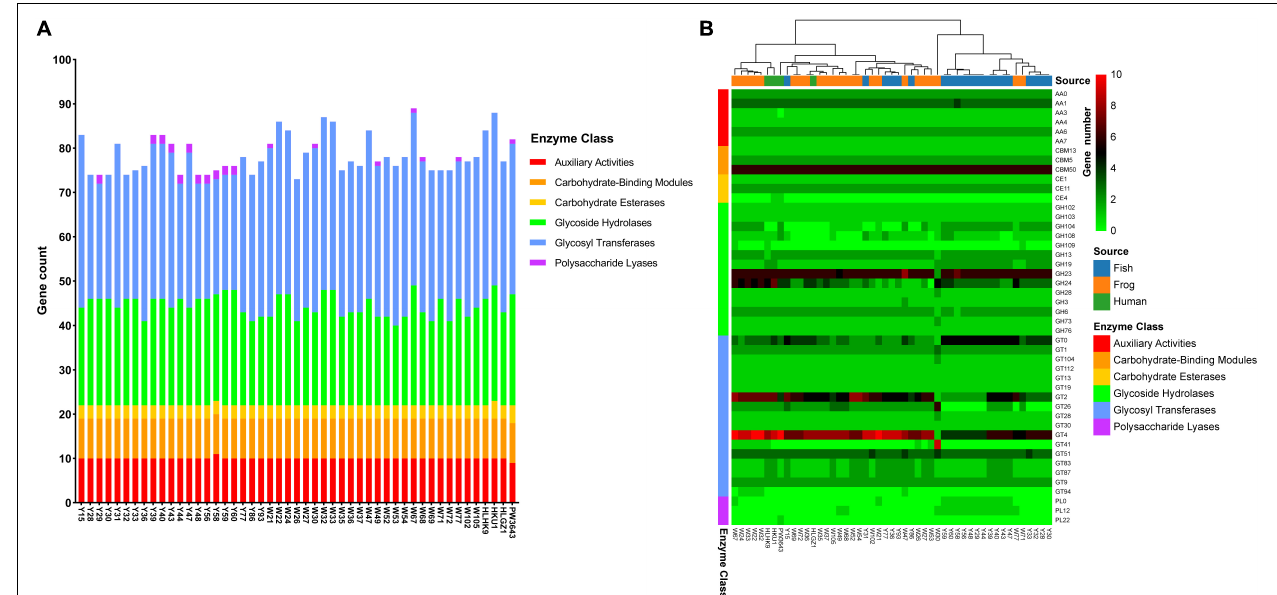
FIGURE 4 | Carbohydrate-Active Enzyme (CAZy) profiles of 49 L. hongkongensis genomes. (A) Stacked bar chart of Carbohydrate-Active Enzymes distributions. (B) Complex heatmap based on gene copy numbers of Carbohydrate-Active Enzymes in each genome. Clustering is only performed on row distance by ward. D2 method. Analysis of the CAZy profiles was annotated using the dbCAN2 resource CAZy family-specific hidden Markov models (HMMs) (Zhang et al., 2018). The sources of strains and the classes of CAZyme modules or domains were represented as colored bars.